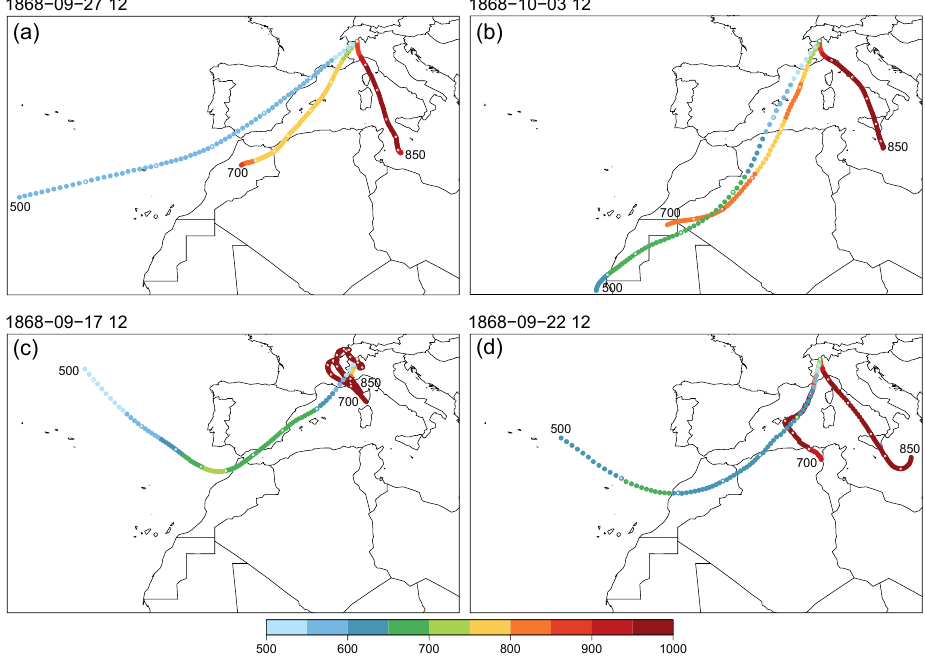
Figure 8. Backward trajectories of 3 days (5 days for panel c ) ending at 850, 700 and 500hPa levels over the grid point 8 ◦ N, 46 ◦ E in 20CR on (a) 27 September 1868 12:00UTC, (b) 3 October 1868 12:00UTC, (c) 17 September 1868 12:00UTC and (d) 22 September 1868 12:00UTC. Color segments indicate pressure levels in hPa along the trajectories. Time steps of 12h are indicated by white dots. The